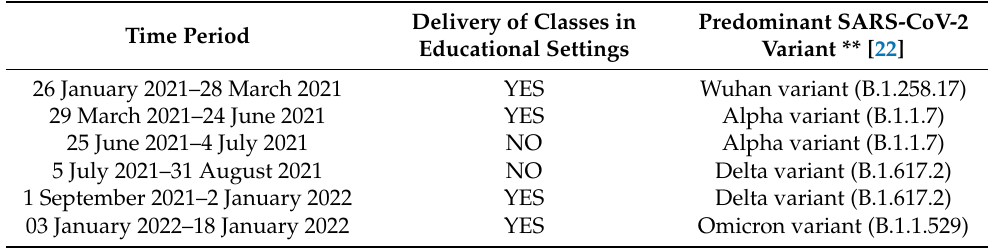
Table 3. Periods of classes in educational premises and the prevalence of each SARS-CoV-2 variant in